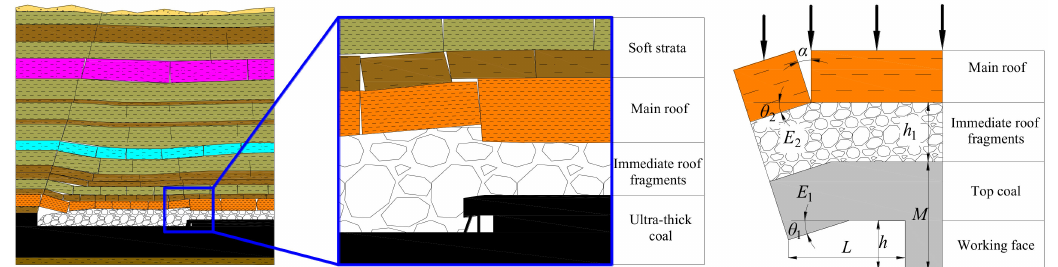
Figure 11. Illustration of the interactions between shields and surrounding rock mass ( h —shield height; M —mining height at each multi-layer extraction; h 1 —immediate roof thickness; θ 1 —top coal rotation angle; θ 2 —main roof rotation angle; L —face width; E 1 —coal elastic modulus; E 2 —elastic modulus of the broken rock mass below the main roof; α —angle of the fracture in the roof.).